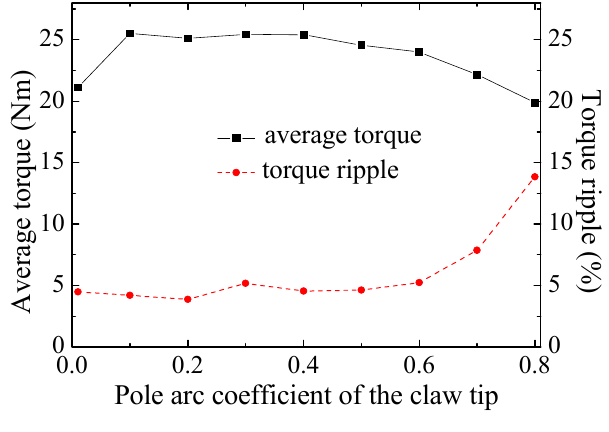
Figure 19. Variation of average torque and torque ripple with pole arc coefficient of the claw